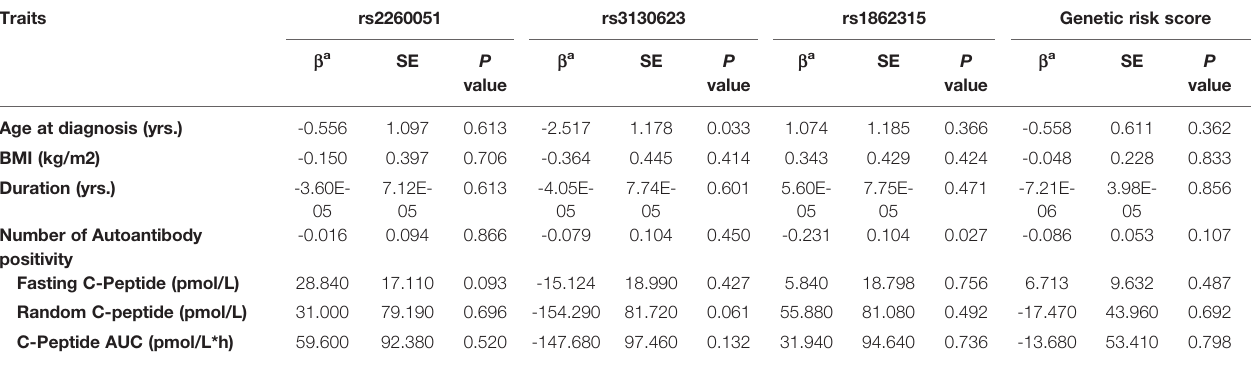
TABLE 4 | Associations of the m6A regulator SNPs with residual islet function in newly diagnosed patients with T1D.